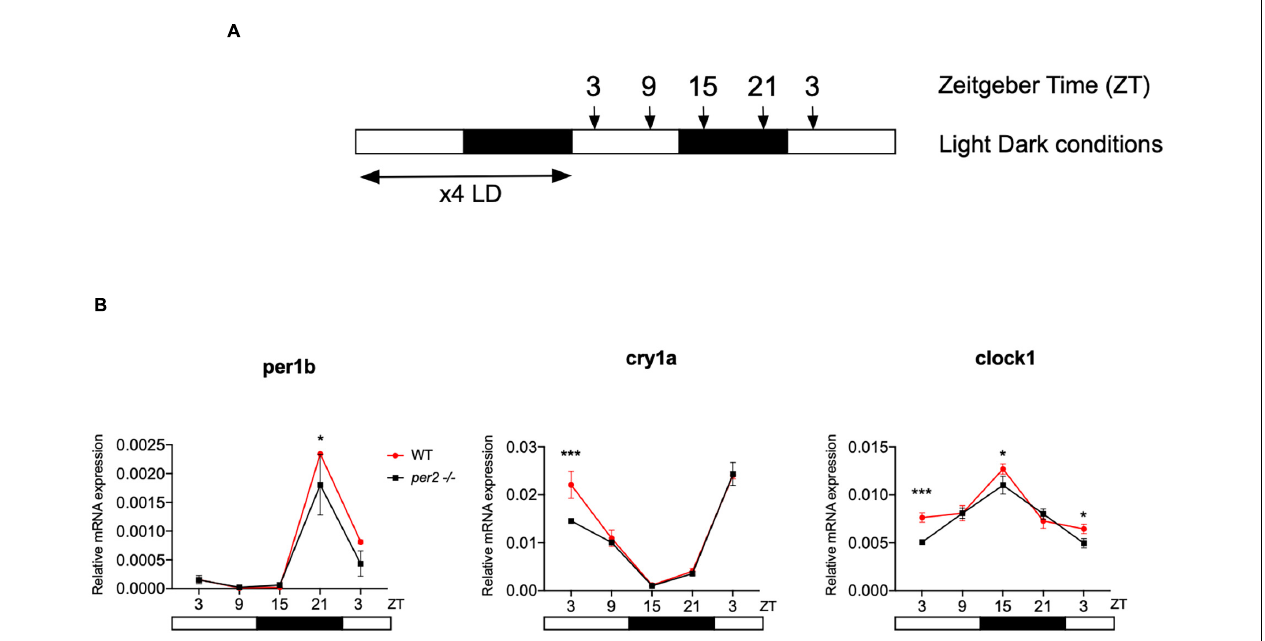
FIGURE 3 | Circadian clock gene expression analysis in per2 KO and WT larvae. (A) Schematic representation of the experimental design. The horizontal bars represent the lighting conditions before and during sampling; white and black boxes indicate light and dark periods, respectively; the arrows show the sampling times. WT and per2 mutant larvae were kept 4 dpf in LD cycle (12 h light-12 h dark) conditions. On the 5th dpf, total RNA was extracted from pools of larvae collected at 6-h intervals during a sampling window of 24 h. (B) qRT-PCR analysis of mRNA expression levels of the circadian clock genes ( clock1 , cry1a , and per1b ) in WT and per2 mutant larvae. Mean mRNA relative expression ( n = 2–3) ± SD is plotted on the y -axis, while zeitgeber time (ZT) is plotted on the x -axis. ZT0 corresponds to lights-on, ZT12 to lights-off. A significant, small decrease in expression level was observed in mutants in all three genes (*** p < 0.001, ANOVA genotype effect, Table 1 ). Asterisks represent levels of significance in comparing the two genotypes at each time point individually, corrected by Sidak’s method (*** p < 0.001, * p < 0.05).